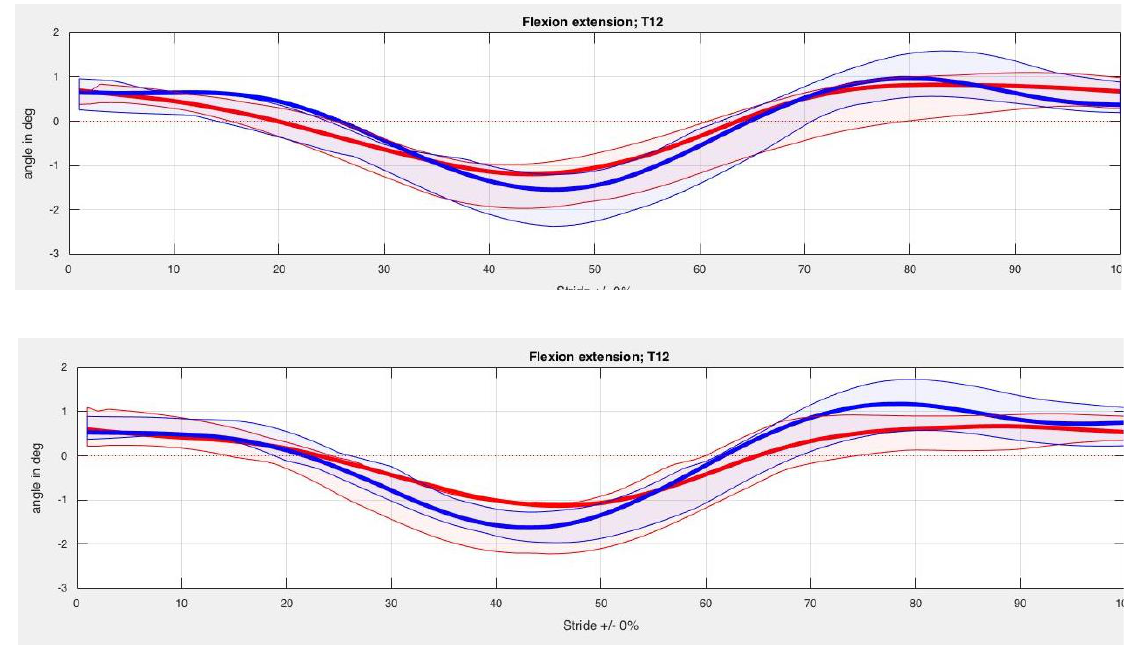
the mean, shaded area the standard deviation. Left hindlimb red and right hindlimb blue.